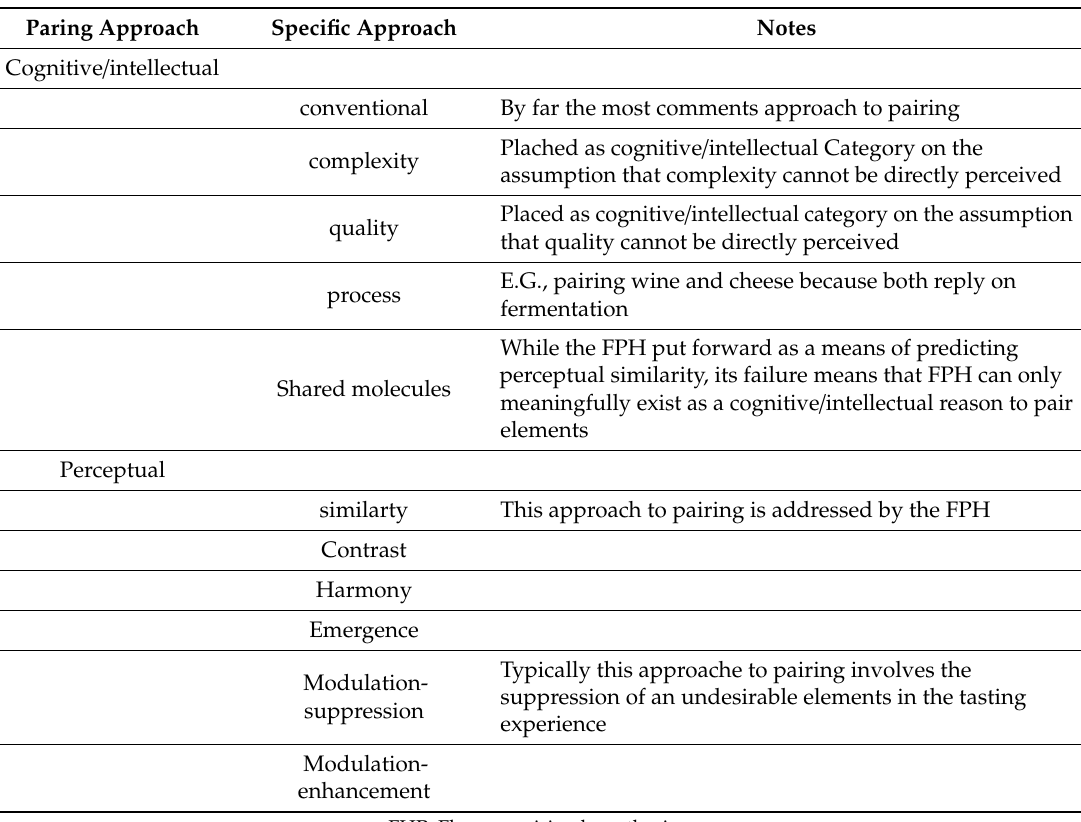
Table 1. Approaches to flavour pairing according to Spence [31]. This table highlights the suggested division of food-beverage pairing approaches into two main categories, with examples of each, and relevant comments, where